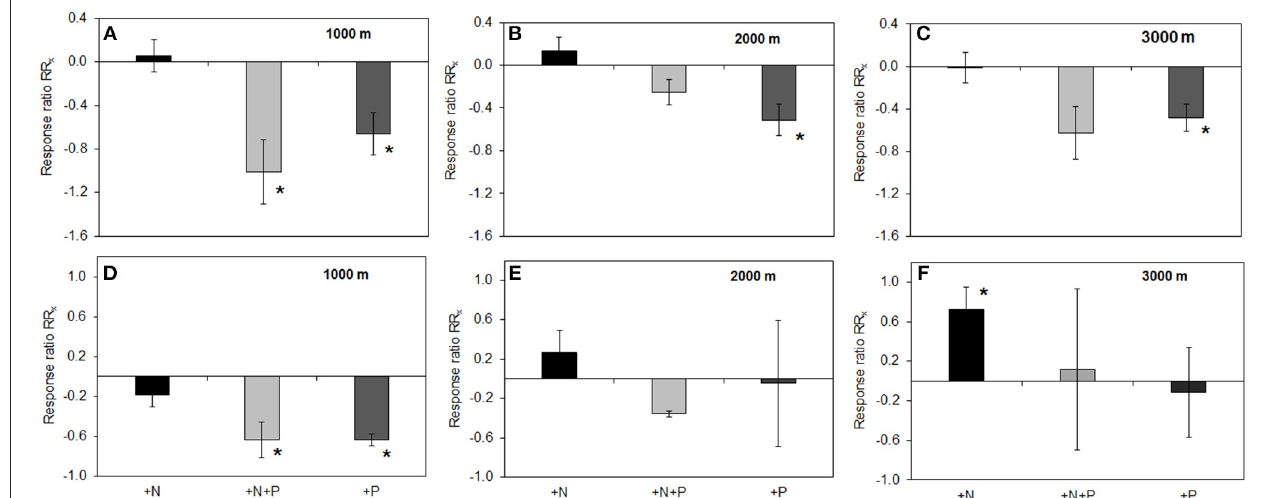
FIGURE 2 | Effects of nutrient addition on phosphomonoesterase activity in the soil. All values represent the effects as natural-log transformed response ratios (RR x ) in which the activity in the fertilized treatments is divided by its value in the control treatment and then ln-transformed. RR x -values are given for altitudes for